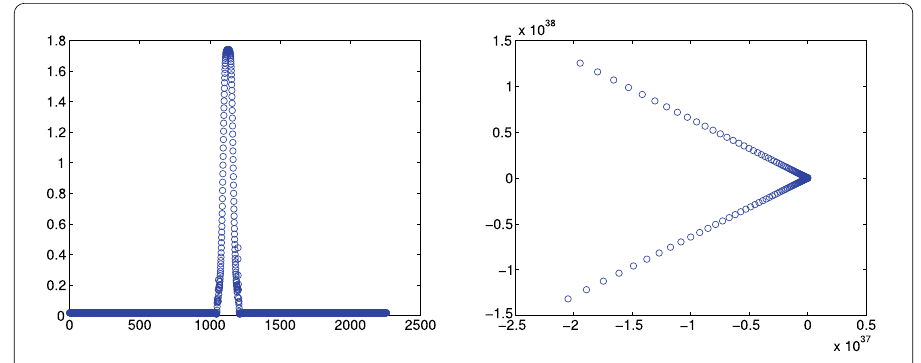
Figure 1 First plot show the stability constant C of our differentiation matrix A for various points along the hyperbolic path. The second plot shows the hyperbolic path, corresponding to Problem